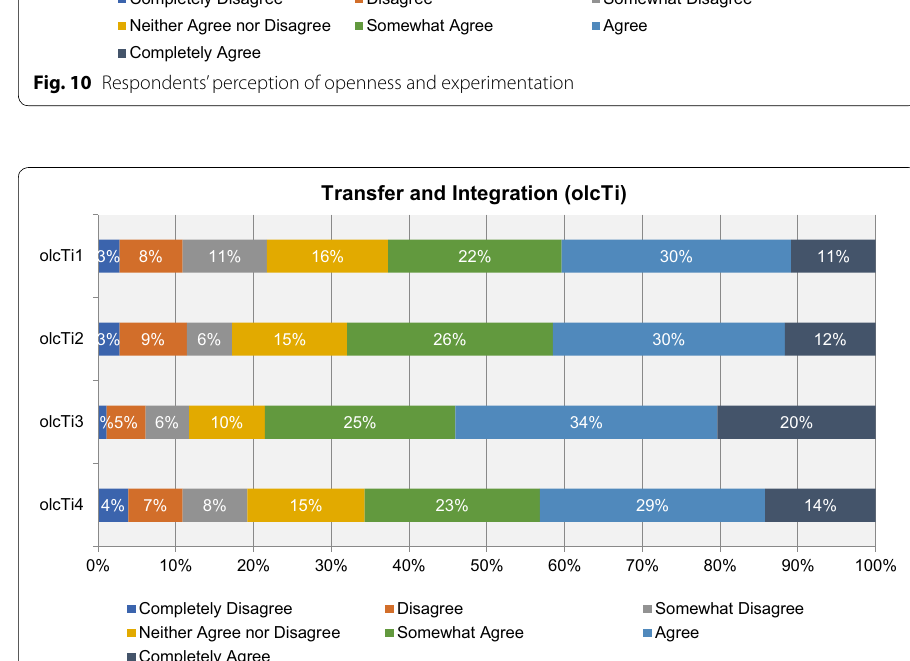
Fig. 11 Respondents’ perception of transfer and integration of